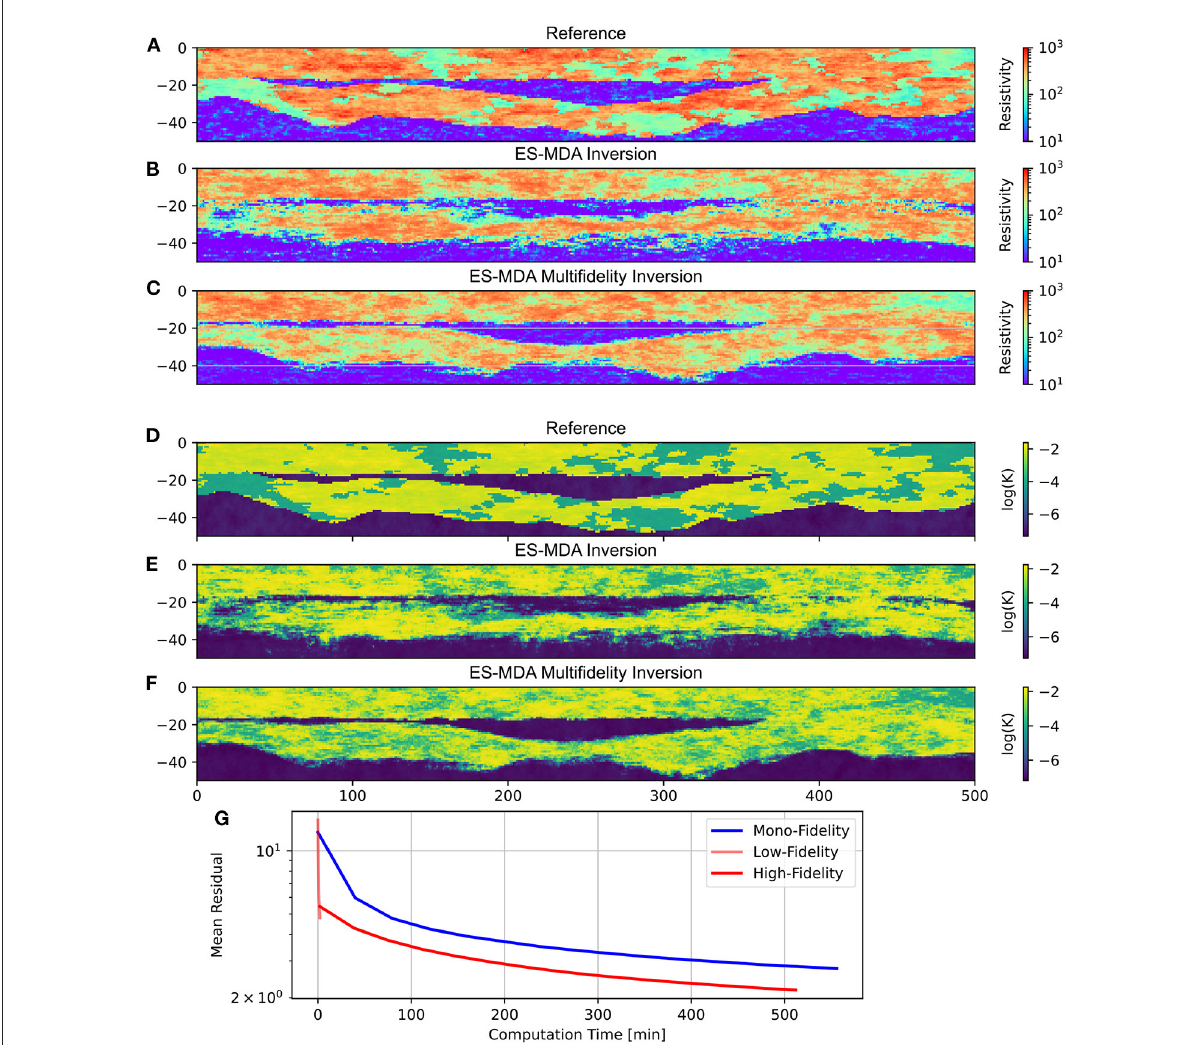
FIGURE9 (A–F) Comparison between the inversion model resulting from a classic ES-MDA inversion, the multifidelity ES-MDA inversion, and the reference model for both the hydraulic conductivities and resistivity fields. (G) The residuals vs. the computation time for the classical ESMDA (monofidelity) and the multifidelity